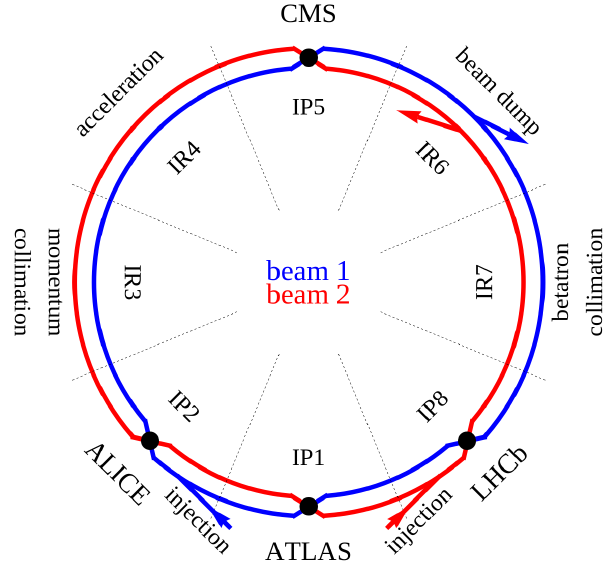
FIG. 1. Top-view schematic of the LHC. There are eight octants, and each octant contains a straight section, shown curved here for simplicity. Beam 1 (blue) goes clockwise, whereas beam 2 (red) goes